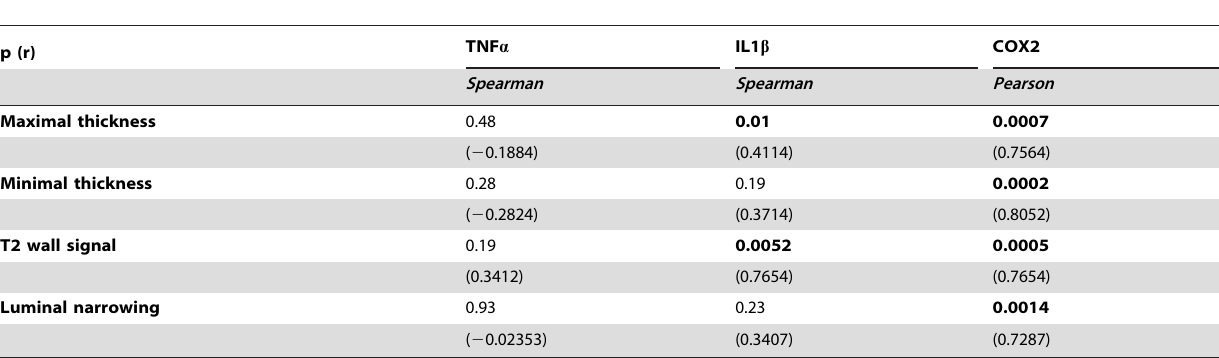
Table 2. Association between MRC criteria and inflammatory